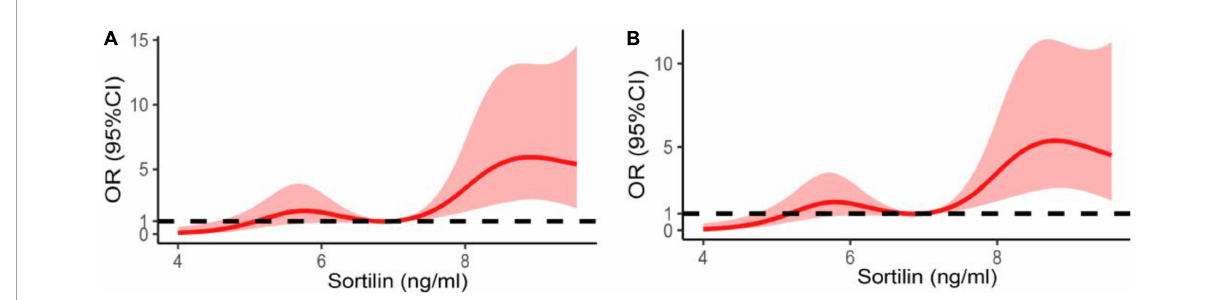
FIGURE3 Restricted spline curve of the plasma sortilin levels and the odds ratio of hypertension. (A) The restricted spline curve of univariable logistic regression model. (B) The restricted spline curve of multivariable logistic regression model. Adjusted for age, sex, BMI, WHR, FAT%, FBG, HbA1c, TG, TC, LDL-C, and